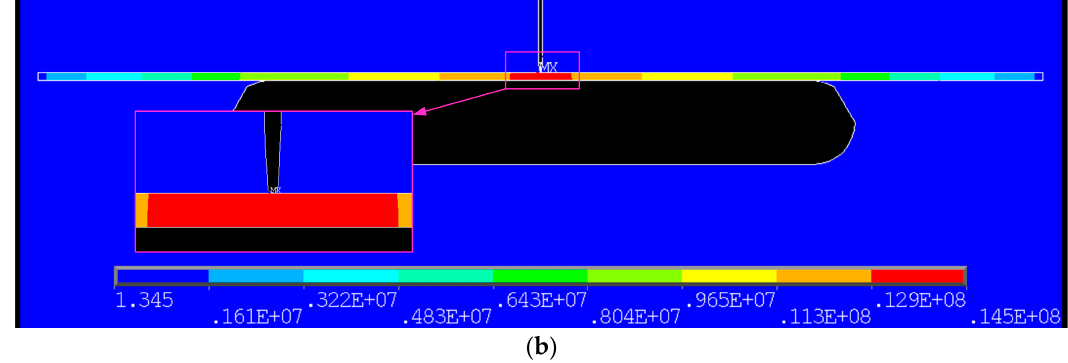
Figure 7. Electric field distribution of needle-plate model under AC and DC voltage components. ( a ) AC voltage component; ( b ) DC voltage component.